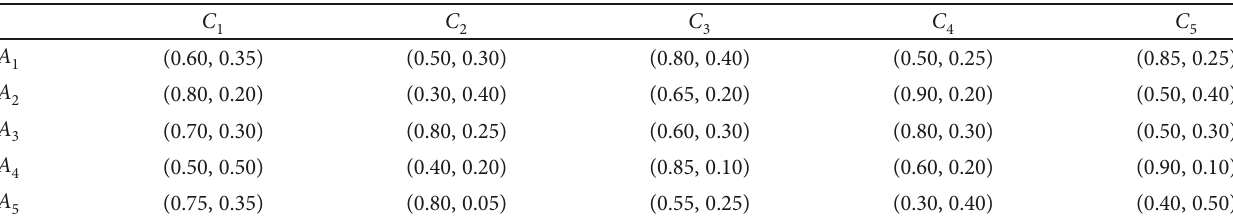
Table 3: Pythagorean fuzzy decision matrix D 3 .